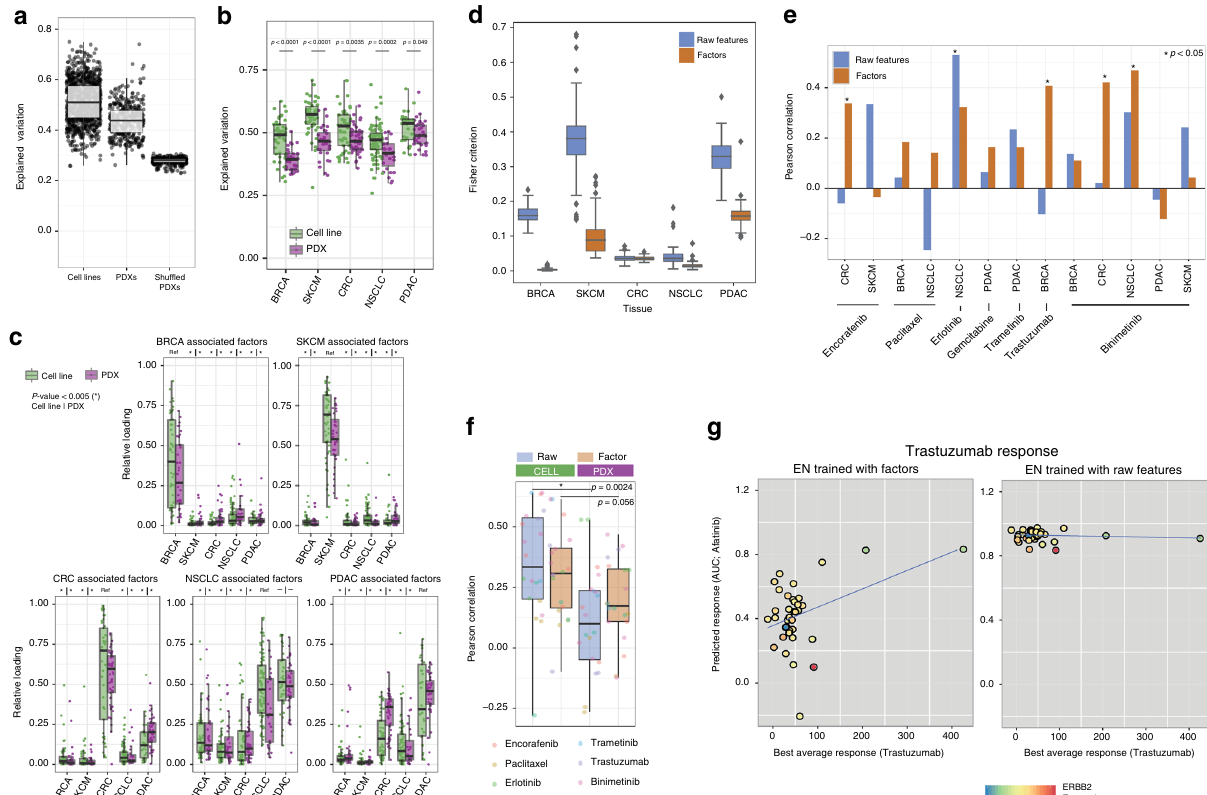
Fig. 5 Application of trained model using pan-cancer cell line data to pan-cancer PDX data. a Explained variation of cell lines, PDXs and permuted PDXs data using cell line-driven gene-factors and DT-factors in boxplots where each point indicates each sample. Standard notations are used for elements of the boxplot (i.e. upper/lower hinges: 75th/25th percentiles; inner-segment: median; and upper/lower whiskers: extension of the hinges to the largest/smallest value at most 1.5 times of interquartile range; also for b , c and f ). b Explained variation of cell lines and PDXs for each of the fi ve tissue types: breast cancer (BRCA), skin cutaneous melanoma (SKCM), colorectal cancer (CRC), non-small cell lung cancer (NSCLC), and pancreatic cancer (PDAC). P -value indicates difference in mean between cell line and PDX. c Relative factor loadings for cell lines and PDXs by factors associated with the cancer type. The signi fi cant difference in loading relative to the reference tissue type ( p < 0.005; t -test) is indicated with an asterisk at the top of each boxplot. d The separation between cell lines and PDXs per tissue type in 100-repeated t -SNE embedding measured by the Fisher criterion in boxplots, strati fi ed by the fi ve tissue types. Blue and orange boxes indicate raw features and factors. Standard notations are used for elements of the boxplot. e Correlation between best average response and predicted drug responses (AUC) using ENs based on raw features and factors, represented in a bar plot. Asterisks indicate drugs with signi fi cant predictive performance ( p < 0.05; Pearson correlation test). f Prediction performance of drugs per tissue type in cell lines (green) and PDXs (purple) using raw (blue) and factors (orange) in a boxplot. Individual color-coded dots represent the compounds used in the analysis. P -values comparing the performance between cell lines and PDXs for each feature are indicated on the top. g Predicted ( x -axis) and measured ( y -axis) response of PDXs to trastuzumab for ENs based on factors (left scatter plot) and raw features (right scatter plot), where each dot is a PDX. Color in the dots indicates expression level the drug target ERBB2 in PDXs. The blue line is the linear regression